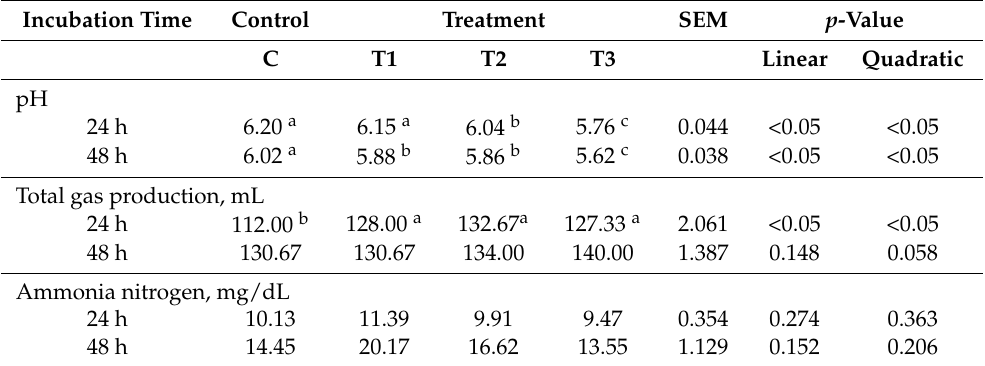
Table 2. Effects of supplemental resveratrol on rumen pH, total gas, and ammonia nitrogen in in vitro ruminal